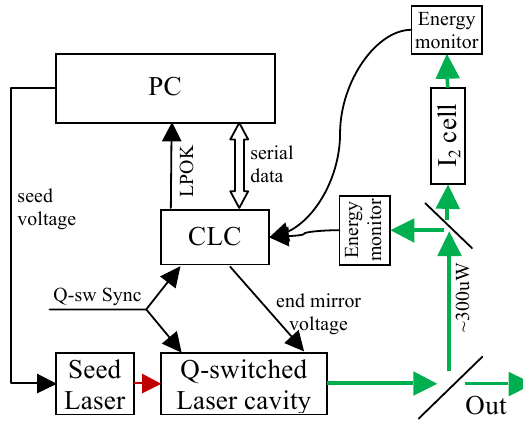
Figure 1: Block diagram of combined cavity length and Iodine locking